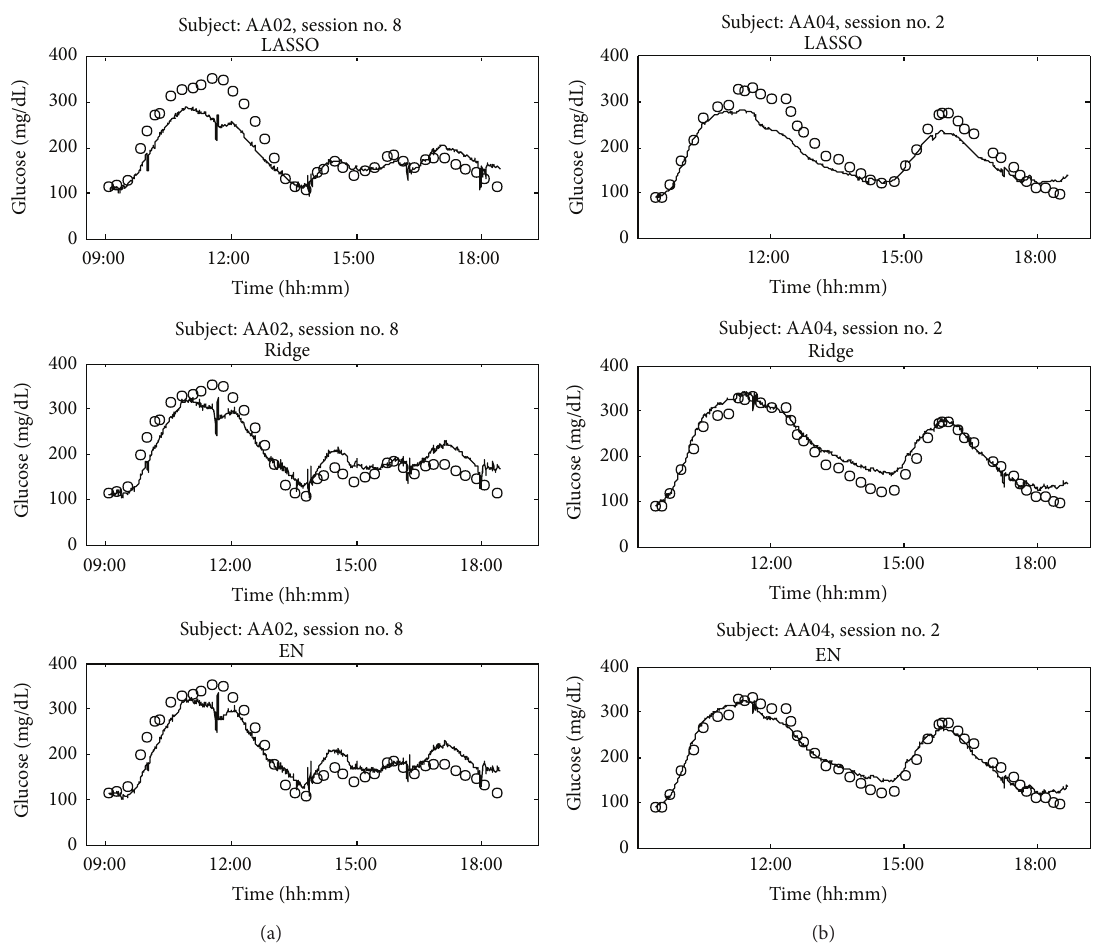
Figure 3: Representative recording sessions of Subjects AA02 (a) and AA04 (b). LASSO, Ridge, and EN models test over independent test data subset (continuous lines) versus RBG levels (open bullets). MARD values for the experimental session on the right are of 16.7% (LASSO), 16.9% (Ridge), and 16.5% (EN), while for the experimental session on the left of 12.7% (LASSO), 11.2% (Ridge), and 9.1%